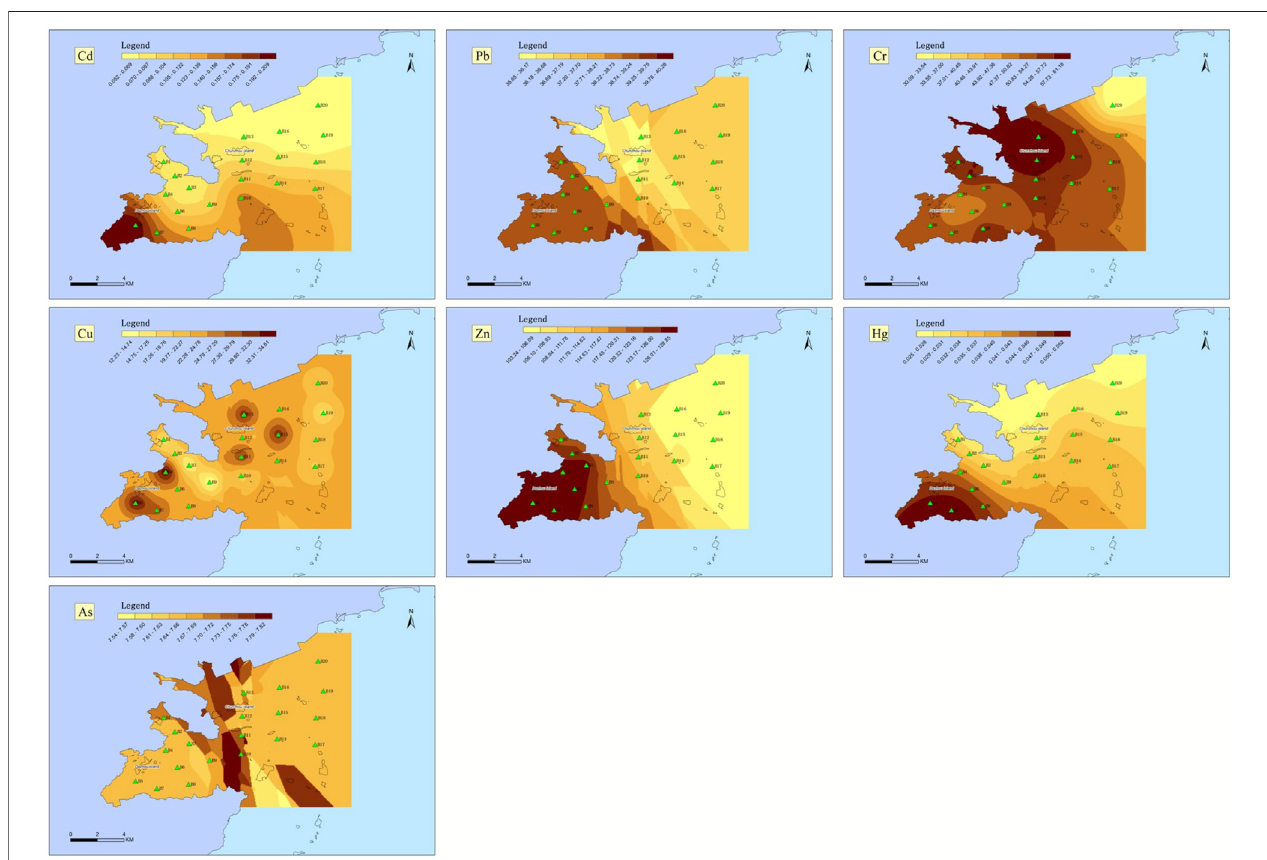
FIGURE 4 | Spatial distribution of heavy metals in surface sediments of the study area in autumn.